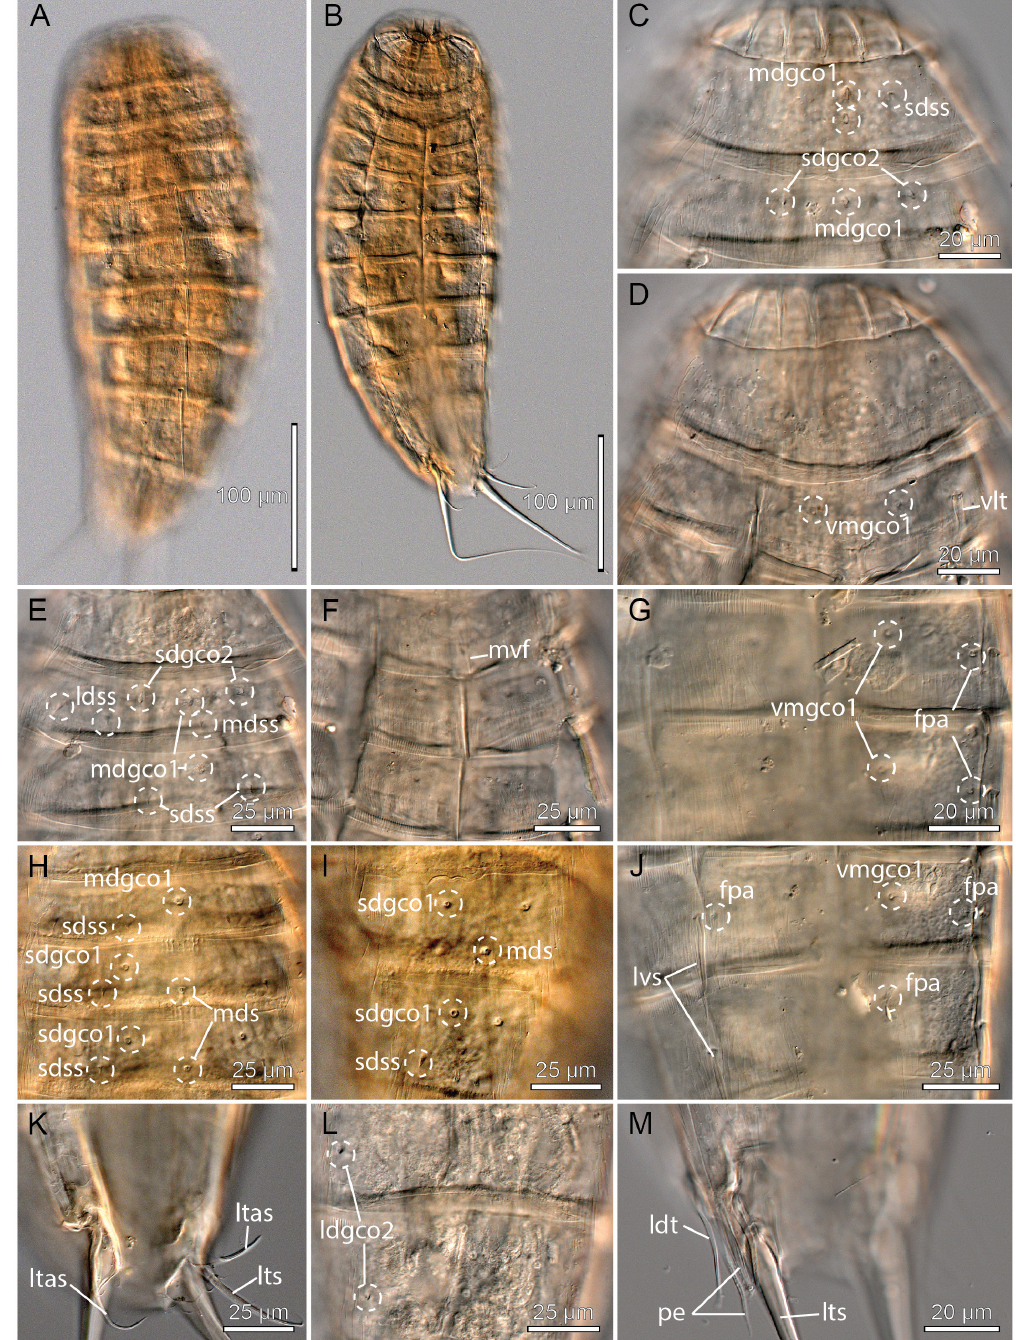
Fig. 9. Light micrographs showing overviews and details of Echinoderes pilosus Lang, 1949. A–B, G–L . Lectotype, ♀ (SMNH-3930a). C–F, M . Paralectotype, ♂ (SMNH-3930b). A . Dorsal overview. B . Ventral overview. C . Segments 1 to 2, dorsal view. D . Segments 1 to 2, ventral view. E . Segments 1 to 3, dorsal view. F . Segments 2 to 4, ventral view. G . Segments 6 to 7, ventral view, showing female sexual dimorphism. H . Segments 3 to 5, dorsal view. I . Segments 8 to 9, dorsal view. J . Segments 7 to 8, ventral view, showing female sexual dimorphism. K . Segments 10 to 11, ventrolateral view, showing female sexual dimorphism. L . Segments 8 to 9, dorsal view but deeper focal plane than (I). M . Segments 10 to 11, ventral view, showing male sexual